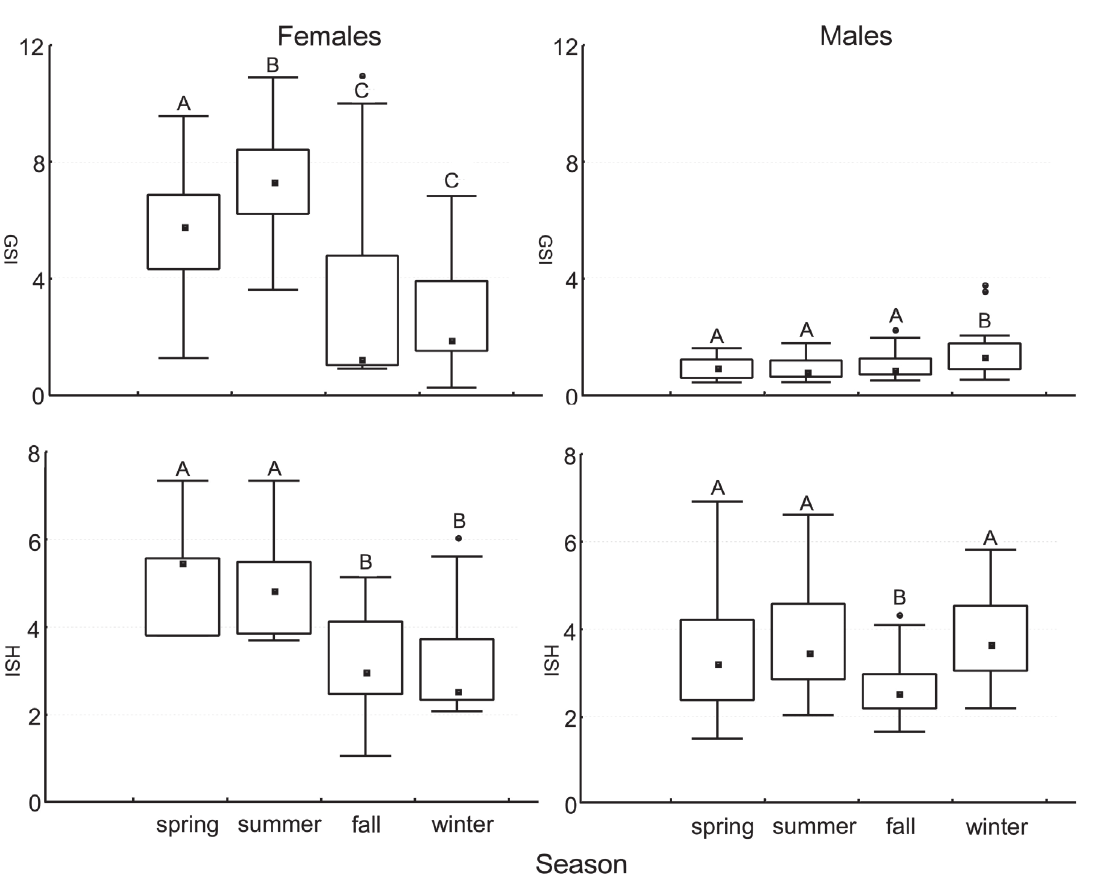
Fig . 1. – Gonadosomatic (Gsi) and hepatosomatic (Hsi) indices of female and male Platyxanthus patagonicus . squared marks: median; box: inter-quartile range; bars: non-outlier range; circles: outliers. Different/equal capital letters on top of the box plots represent significant/non- significant differences between seasons (Kruskal Wallis tests, P<0.05 and t statistic tests comparisons between pairs of treatments,